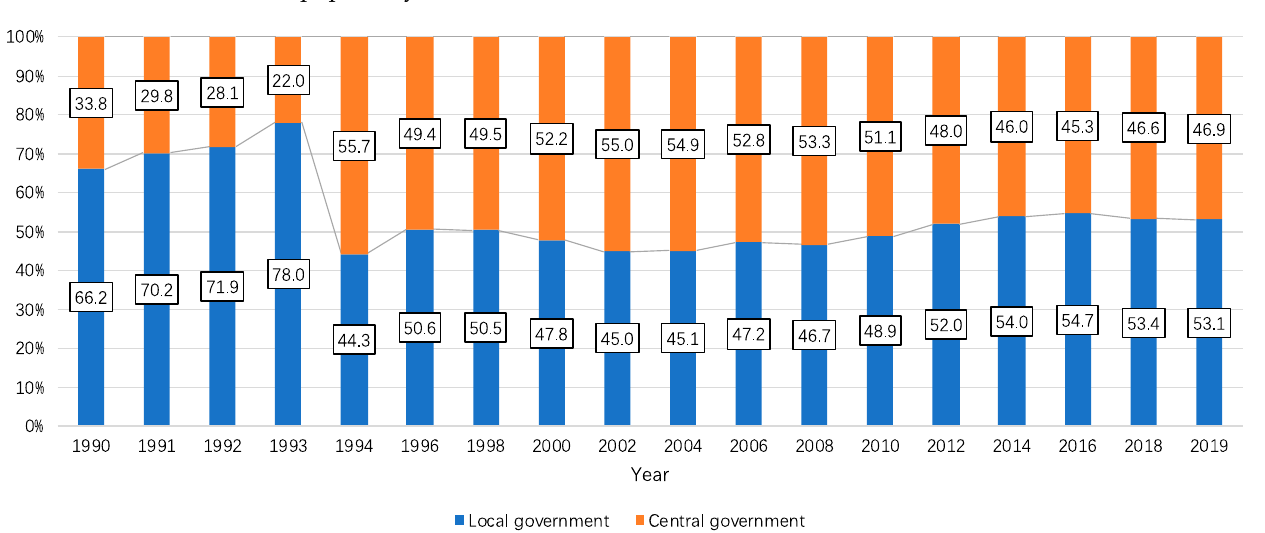
Figure 1. Proportions of central and local fiscal revenue (by the first